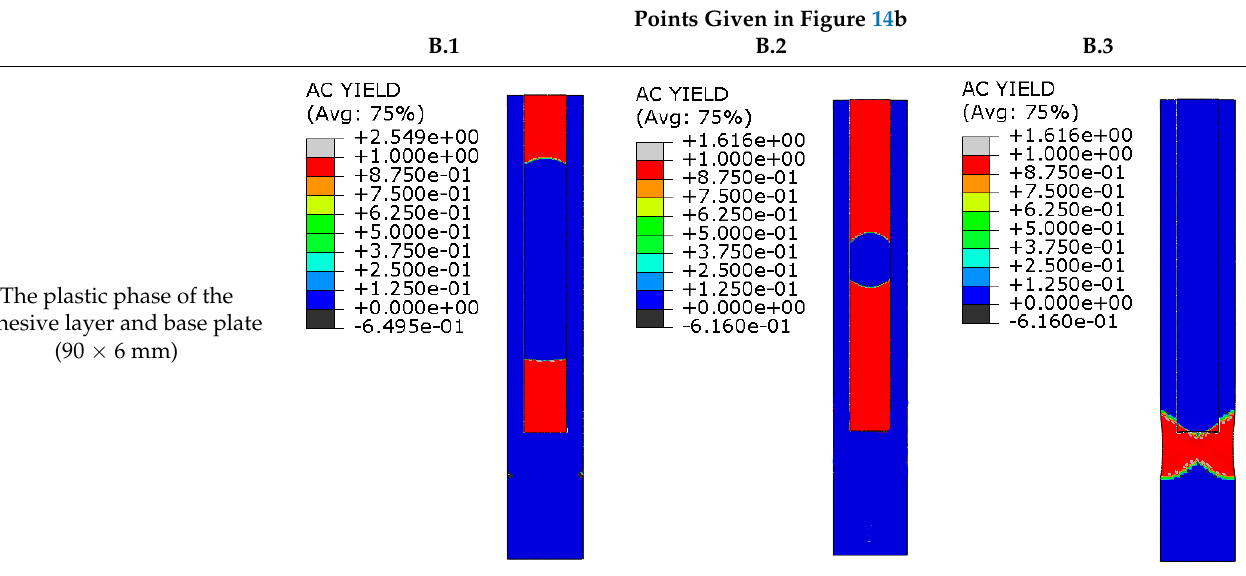
Table 6. Tensile and shear properties of adhesive.